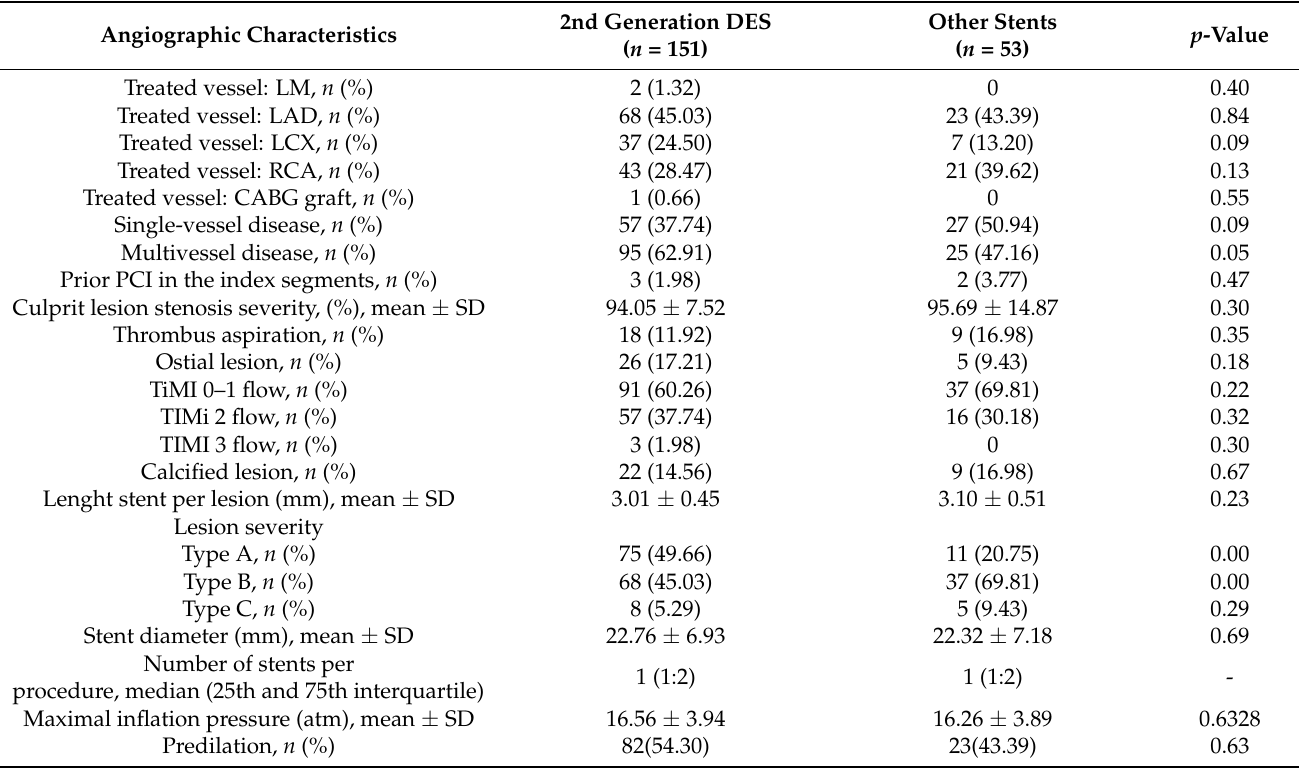
Table 5. Baseline angiographic characteristics of patients underwent